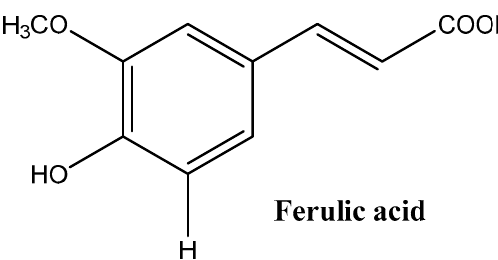
Figure 4. Chemical structure of ferulic acid